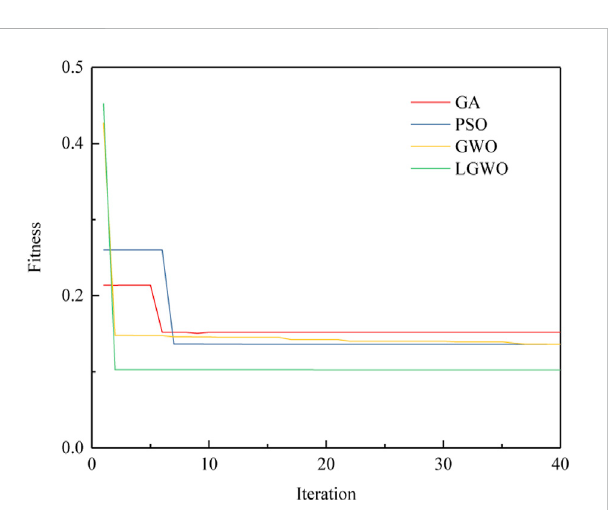
FIGURE 13 Convergence curves of the fi ve algorithms over 20 independent runs.